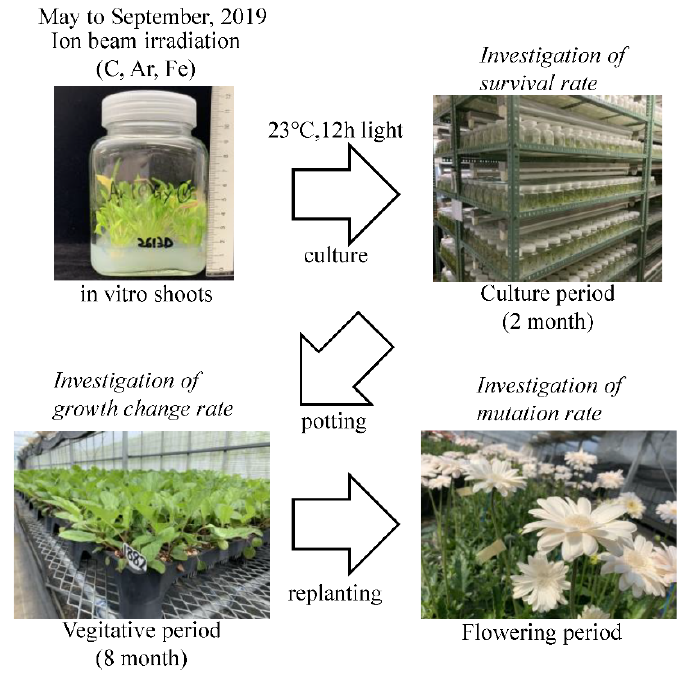
Figure 1. Outline of cultivation and investigation in the present study.